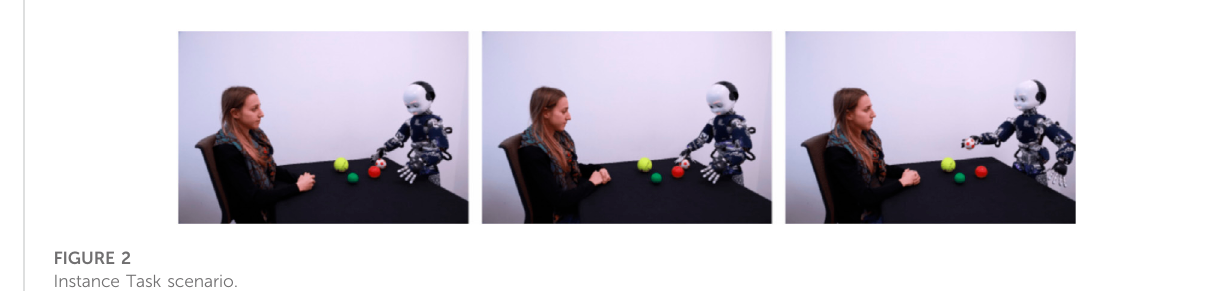
FIGURE 2 Instance Task